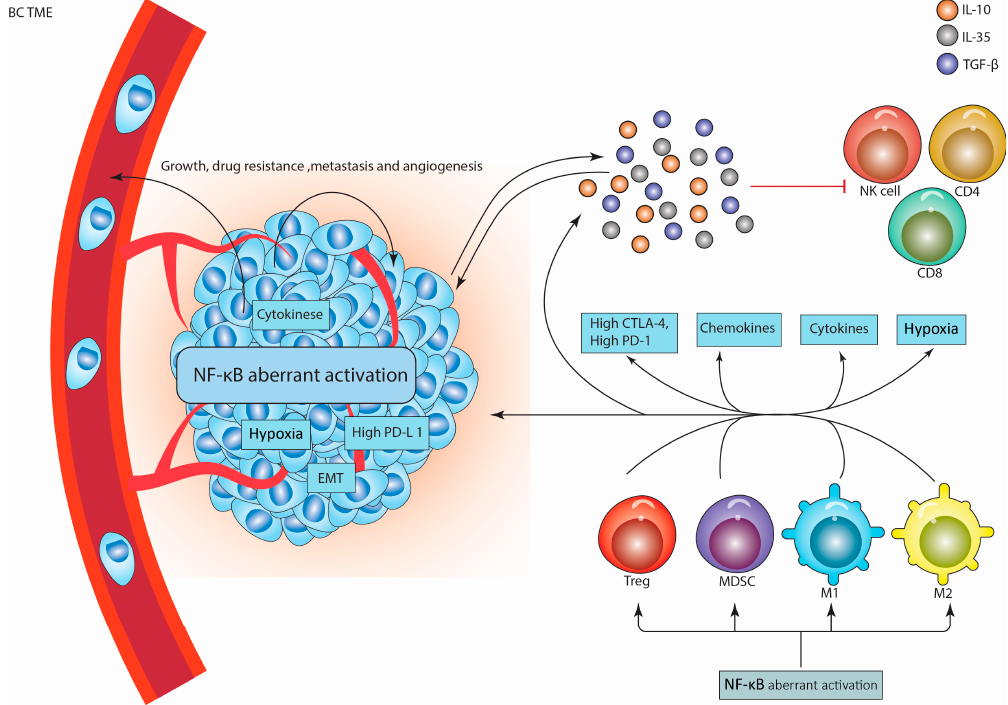
Figure 4. NF- κ B aberrant expression recruits immunosuppressive cells in BC microenvironment. Fol- lowing NF- κ B activation in the immunosuppressive cells in addition to BC cells, together they